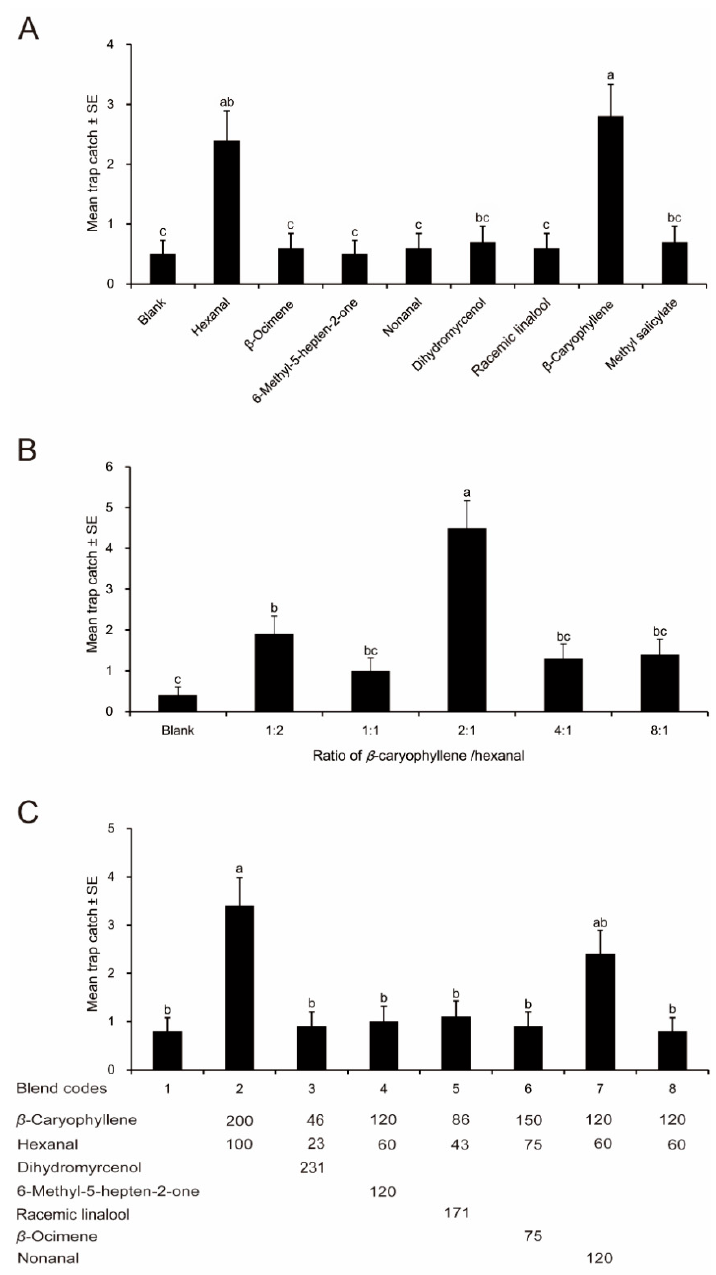
Figure 2. Adults of H. parallela captured in traps with synthetic compounds in Cangzhou, Hebei Province, China. Columns with different lowercase letters are significantly different at α = 0.05 (N = 10, Poisson regression with Bonferroni correction). ( A ) Individual synthetic compounds; ( B ) Dif- fering β -caryophyllene/hexanal ratios; ( C ) β -Caryophyllene/hexanal blend plus differing plant volatile components. Blend codes are the code numbers of treatments, the values under the blend code indicate the amount of each compound in a treatment.